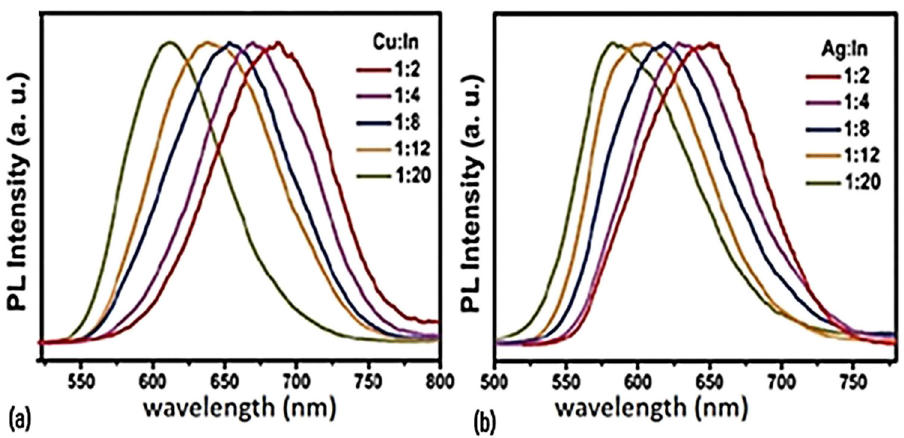
Figure 1: ( a ) PL spectra of CISe/Zns, ( b ) AISe/Zns core shell/QD at various Cu/In and Ag/In precursor ratios; with permission from ref. [ 27 ] ; Green